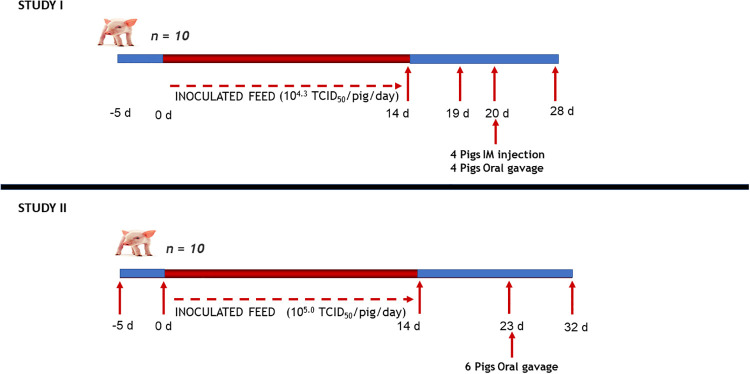
Chronological scheme of studies I and II.In the study I, at day 20, 4 pigs received IM injection of 10 mL Liquid ASFV inoculated plasma. Dose = 104.3 TCID50/pig. Other 4 pigs received an oral gavage of 50 mL Liquid ASFV-inoculated plasma. Dose = 105.1 TCID50/pig. In study II, at day 23, 6 pigs were oral gavaged with 50 mL Liquid ASFV-inoculated plasma. Dose = 105.7 TCID50/pig.